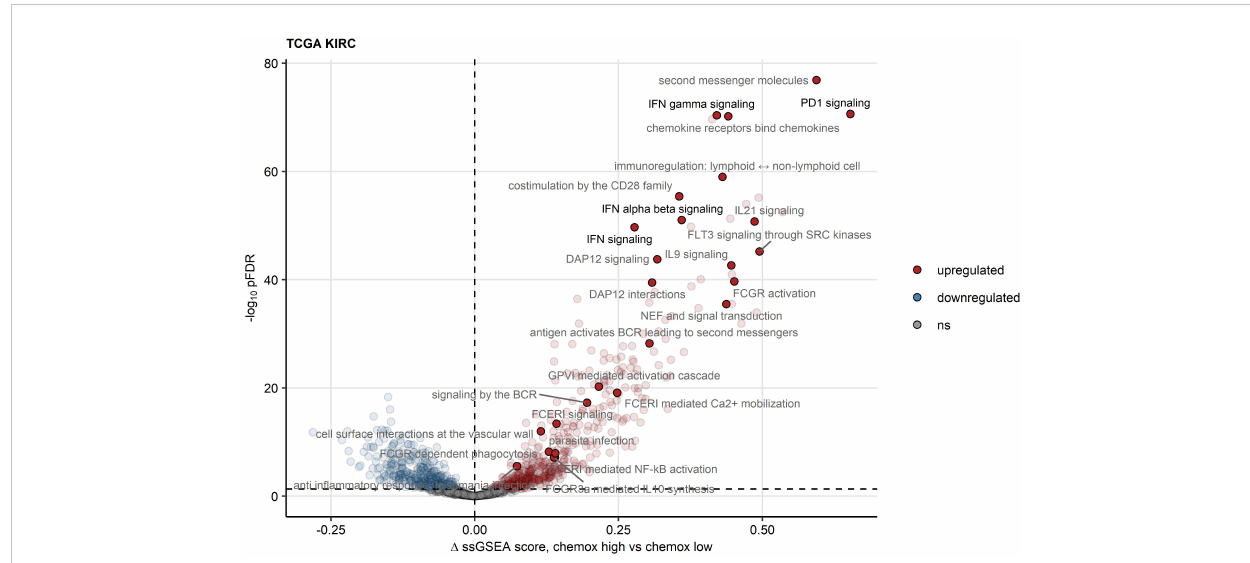
FIGURE 7 Reactome pathway gene signatures signi fi cantly regulated between the two chemokine clusters. Single sample gene set enrichment analysis (ssGSEA) scores for Reactome pathway gene signatures (n = 1615) were compared between chemokine (chemox) high and chemokine low RCCs by false discovery rate (FDR) corrected two-tailed T test. Signi fi cance and estimated differences in ssGSEA scores for the TCGA KIRC cohort are presented in a volcano plot. Points represent single genes, point color codes for the regulation sign. The signi fi cance cutoff is visualized as a dashed line. Reactome pathway signatures found to be signi fi cantly regulated in all investigated cohorts are highlighted and labeled with their